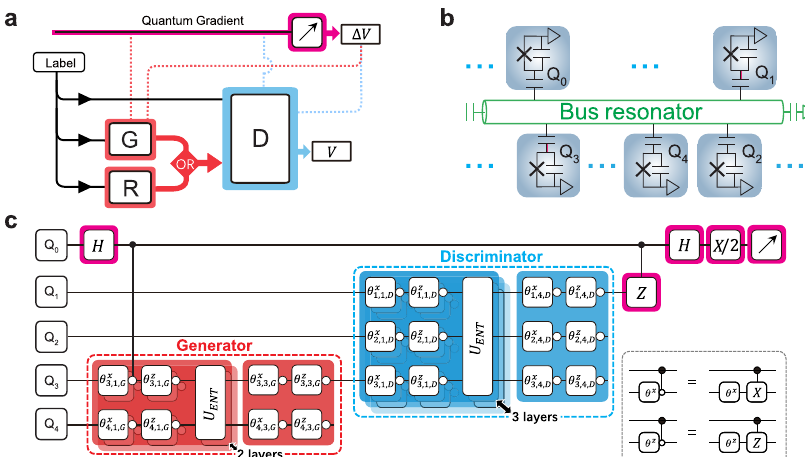
Fig. 1 QGAN algorithm and its implementation. a Overview of the QGAN logic. b Sketch of the superconducting processor used to implement the QGAN algorithm, where the fi ve qubits, Q 0 – Q 4 , are interconnected by the central bus resonator. c An instance of the experimental sequences for ful fi lling the QGAN algorithm to learn the classical XOR gate. Both G and D are parameterized quantum circuits consisting of n layers of the multiqubit entangling gate U ENT and n + 1 single-qubit rotations θ x = z qubit rotations, m ∈ {G, D}, and the superscript ( x or z ) refers to the axis in the Bloch sphere around which the state of Q j is rotated by the angle θ . Shown is the training sequence on G to optimize its parameter θ x Hadamard gates ( H ), two controlled rotation gates, and a π /2 rotation around x -axis ( X /2). In this instance, both Q 1 – Q 2 and Q 3 – Q 4 store the input label, and D ’ s output score is encoded in Q 1 by S D ; R = G the score derivative with respect to the rotational angle parameter right before the fi rst controlled rotation gate, i.e., ∂ h σ z the sequence displayed here. The fi rst controlled rotation gate can be either a controlled X (CNOT) or controlled Z (CZ) gate depending on the single-qubit rotation axis it follows as shown in the lower right